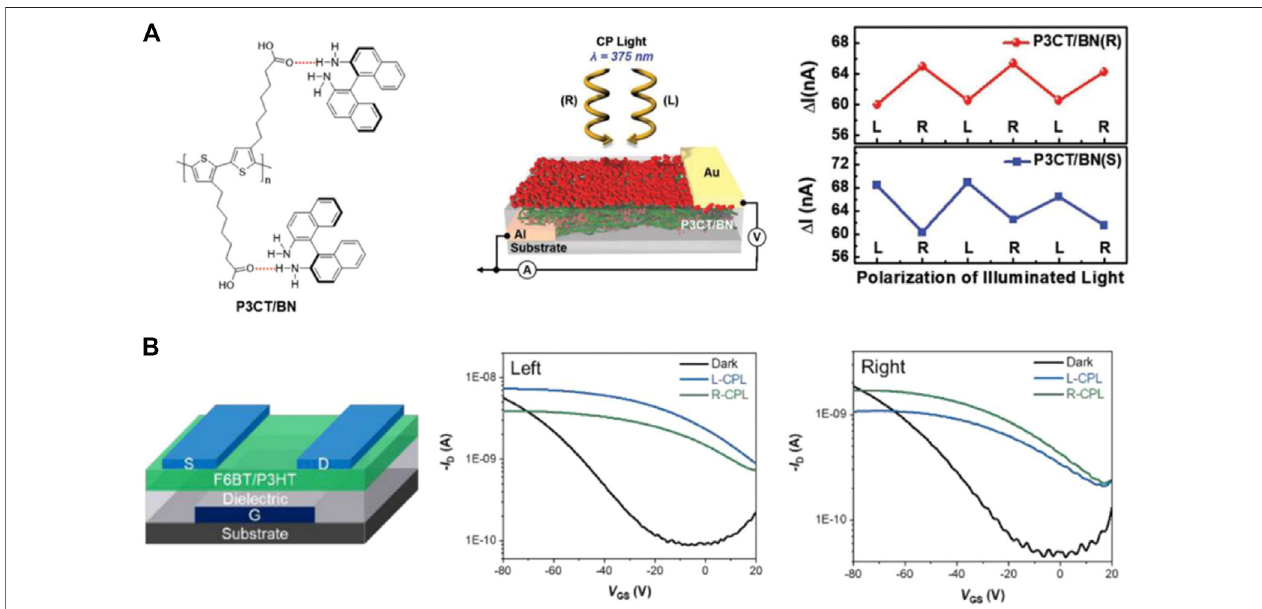
FIGURE 5 | (A) Chemical structures of P3CT and BN and a schematic illustration of the hydrogen bonding interactions leading to the formation of a P3CT and BN hybrid system.Devicestructureofthephotodiodebasedon theP3CT/BNhybridthin fi lm. Variation inthemaximum photocurrent ofthephotodiodesbased onaP3CT/ BN ( R ) and P2CT/BN ( S ) hybrid thin fi lm under the illumination of LCPL and RCPL, respectively (Kim et al., 2019). Reproduced with permission. Copyright 2015, Wiley- VCH. (B) Schematic structure of the phototransistor based on the F6BT/P3HT blended thin fi lm and transfer curve of the enabled F6BT/P3HT OFETs under the illumination of LCPL and RCPL (Cheng et al., 2020b). Reproduced with permission. Copyright 2020, The Royal Society of Chemistry.